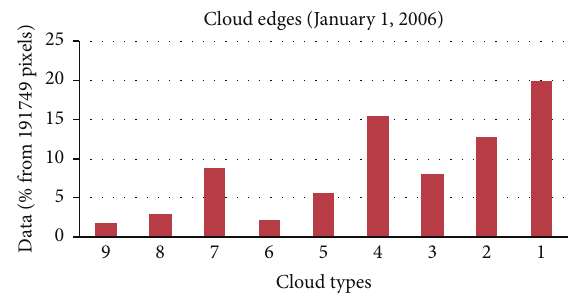
Figure 1: Edge distribution among the different cloud types. 1: cirrus, 2: cirrostratus, 3: deep convection, 4: altocumulus, 5: alto- stratus, 6: nimbostratus, 7: cumulus, 8: stratocumulus, and 9: stratus. The graph shows that the cirrus, altocumulus, and cumulus clouds are more likely to have edges than the other types of clouds. This histogram is based on NOAA-AVHRR CTT satellite images of the Globe at a spatial resolution of 0.5 degree. The gradients from which the cloud types are derived are associated with the corresponding areas of cloud top pressure images and matched with the cloud type classification map of a commonly used method in cloud remote sensing, the ISCCP method (based on the cloud optical depth and the cloud top pressure). The more edges exist in a specific area, the more the cloud encountered is